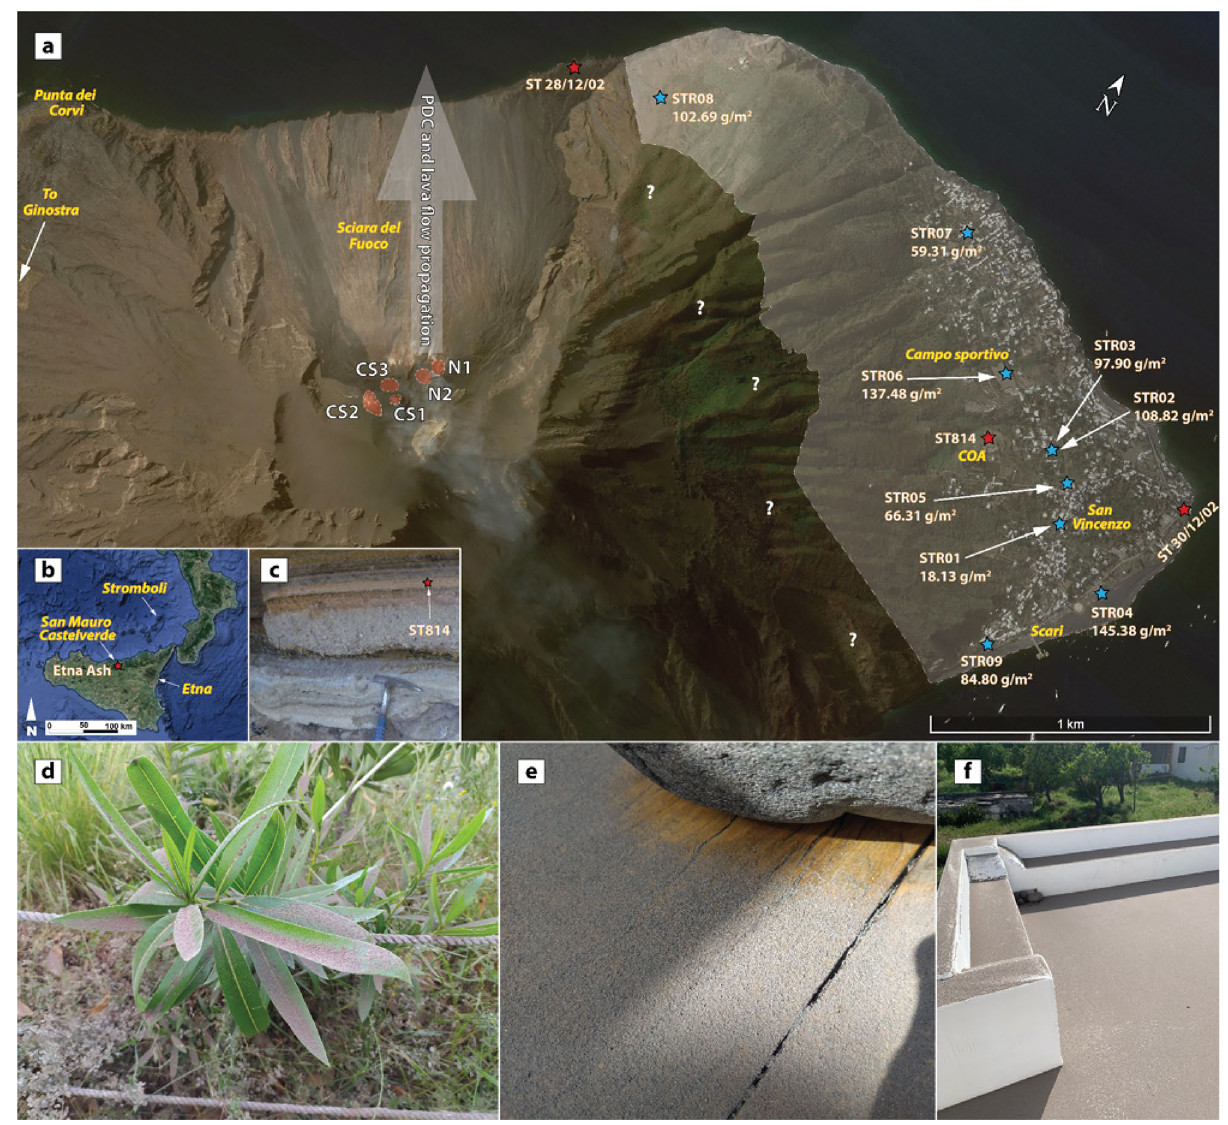
Figure 2. ( a ) Map of the northern portion of Stromboli island (Google Earth@2022 Map data SIO, NOAA, U.S.Navy, NGA, GEBCO). White-dashed red-filled shapes indicate the summit craters (N1, N2—Northeast craters; CS1, CS2, CS3—Central-South craters). The shaded arrow approximately indicates the propagation direction of the PDC and lava flow. The blue stars in the map indicate the sampling locations of the 19 May 2021 ash cloud deposit, and for each sample is annotated the mass value (g/m 2 ). The red stars indicate the sampling locations of three samples used as comparison, for instance the 28 December 2002 (ST281202), the 30 December 2002 (ST301202) and the COA ash tuff (ST814). The white shaded area delimits the ash fall dispersion (question marks indicate that it was not possible to verify whether the ash cloud deposit occurred at higher elevations). Toponyms are in yellow and italics. The inset picture ( b ) illustrates a regional view of Sicily, and the red star marks the sampling location of 22 February 2021 Etna Ash (Google Earth@2022 Map data Landsat/Copernicus, SIO, NOAA, U.S.Navy, NGA, GEBCO). The inset picture ( c ) depicts the COA pyroclastic sequence, and the stratigraphic position of ST814 is annotated. Photos ( d ),( e ) and ( f ) detail the tephra deposit investigated in this paper. In particular, picture ( f ) corresponds to the location of samples STR02 and